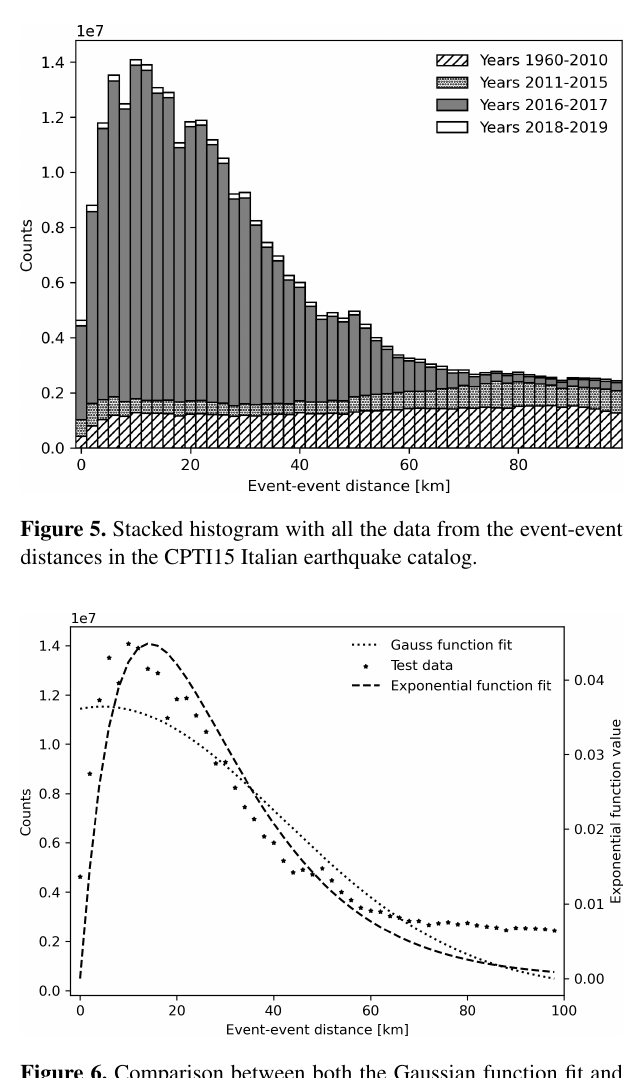
Figure 6. Comparison between both the Gaussian function fit and exponential-like function fit for the stacked counts in the event- event distance distribution for the Italian